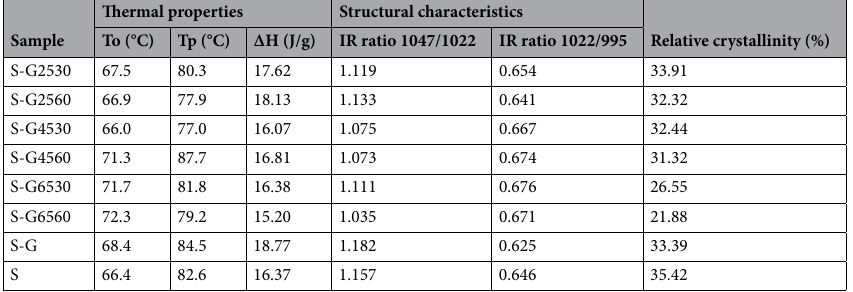
Table 3. Thermal properties, structural characteristics, and relative crystallinity (%) of thermal-ultrasound treated samples. Each value is the average of three independent experiments.